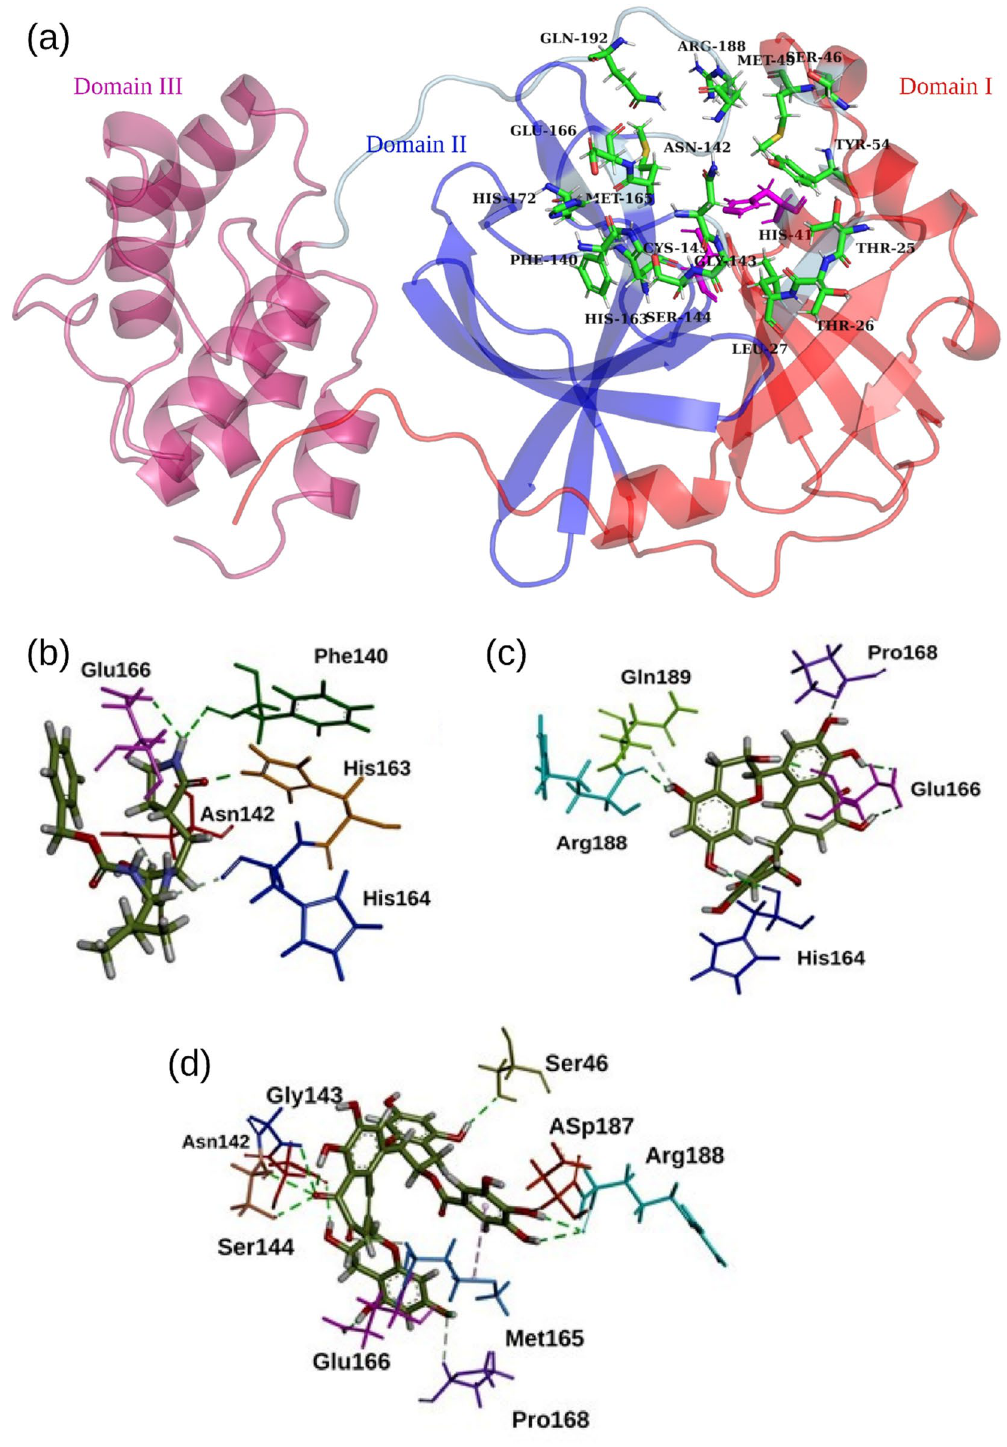
Figure 3. Analysis of docking results. ( a ) Different domains of M pro and 3D representations of docking poses for ( b ) GC373, ( c ) theaflavin, and ( d ) theaflavin